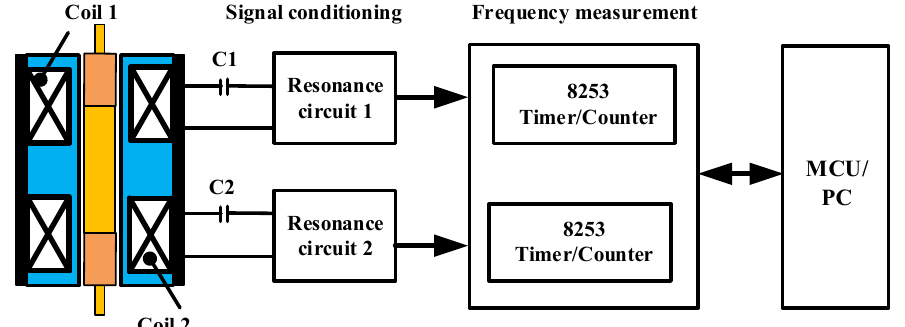
Figure 4. Block diagram of a signal conditioning circuit based on discrete devices.